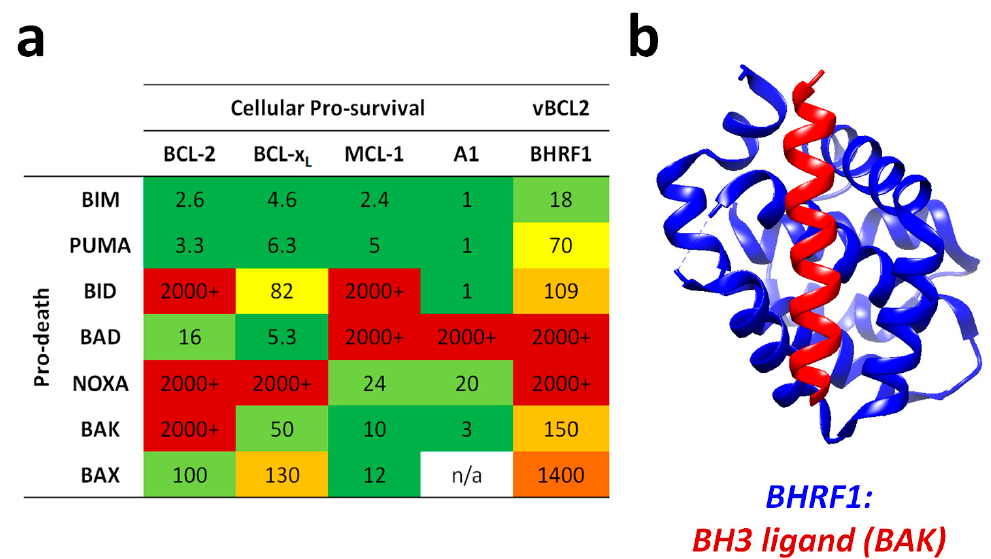
Figure 3. Binding specificities and affinities of BCL-2 family members and EBV BHRF1. ( a ) Interactions between pro-survival and pro-death BCL-2 family members. Reported as K d in nM as determined by surface plasmon resonance (BCL-2, BCL-x L and MCL-1) or isothermal calorimetry. Sources were: BCL-2 and BCL-x L [144–146], MCL-1 [144], A1 [147] and BHRF1 [124,133]. Colour coding was applied as follows: green 1–10 nM, pale green 11–50 nM, yellow 51–100 nM, pale orange 101–1000 nM, orange 1001–2000 nM, red 2000–100,000 nM. ( b ) Ribbon structure representation of BHRF1 (blue) bound to the BH3 domain of BAK (red). This graphic was prepared using the UCSF